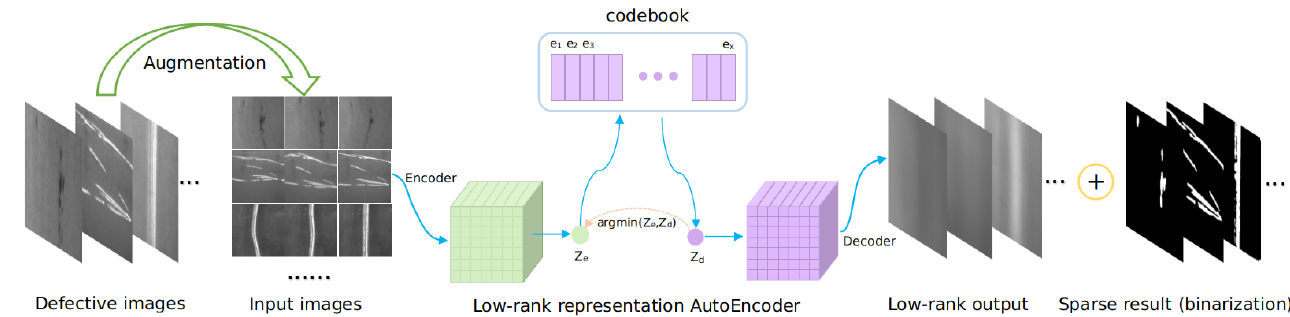
Figure 1. Architecture of our low-rank representation quantized network. The sparse result is postprocess with binarization to compare with ground truth. Both encoder E and decoder D contain 4 convolutional layers with size 4 × 4 and step ( 2,2 ) . The codebook contains 2000 code and each code is 8